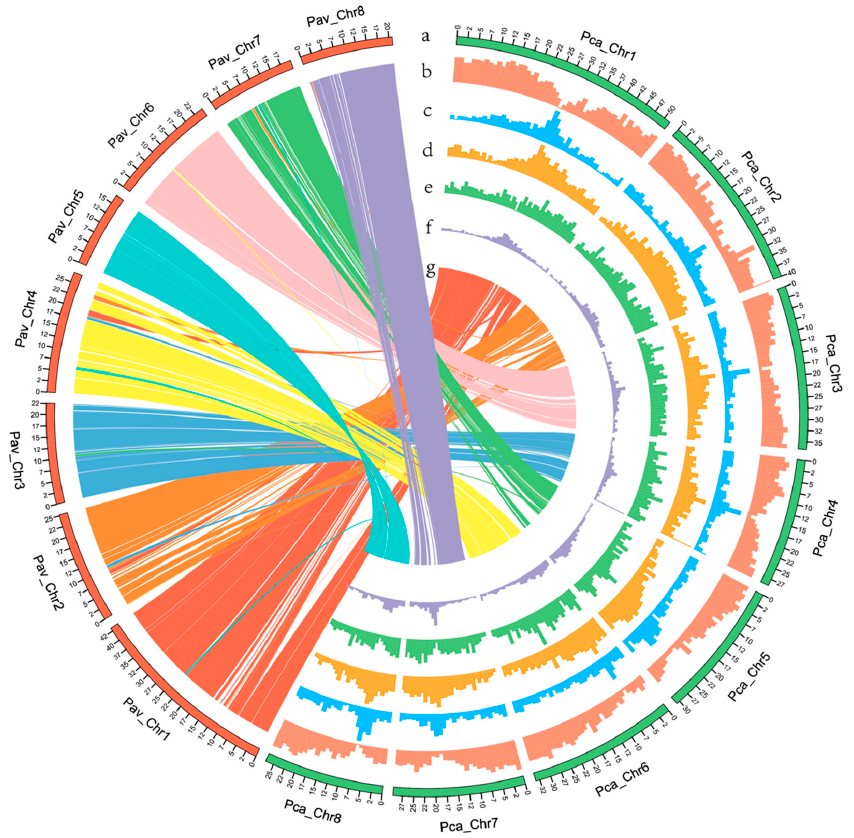
Figure 3. Circular diagram depicting the characteristics of P. campanulata genome. ( a ) Genome of P. campanulata . ( b ) Gene density in 1 Mb sliding windows. ( c ) GC content in 1 Mb sliding windows. ( d ) Repeat density in 1 Mb sliding windows. ( e ) Copia density in 1 Mb sliding windows. ( f ) Gypsy density in 1 Mb sliding windows. ( g ) Syntenic relationships of gene pairs between P. campanulata and P. avium genomes using the best-hit method. Pca: P. campanulata ; Pav: P. avium . We identified 28,319 protein-coding genes in the P. campanulata genome, with an av- erage transcript length of 3135 bp, an average CDS length of 1226 bp, and an exon number of 4.75 per gene (Table 3). In addition, 26,352 protein-coding genes were annotated with ≥ 1 database, accounting for 93.1% of the annotated protein-coding genes (Table S5). For the identification of non-coding RNA (ncRNA), a total of 2230 ncRNAs were predicted, in- cluding 562 microRNA, 721 tRNA, 330 rRNA, and 617 small nuclear RNA, accounting for approximately 0.10% of the P. campanulata genome (Table S6).